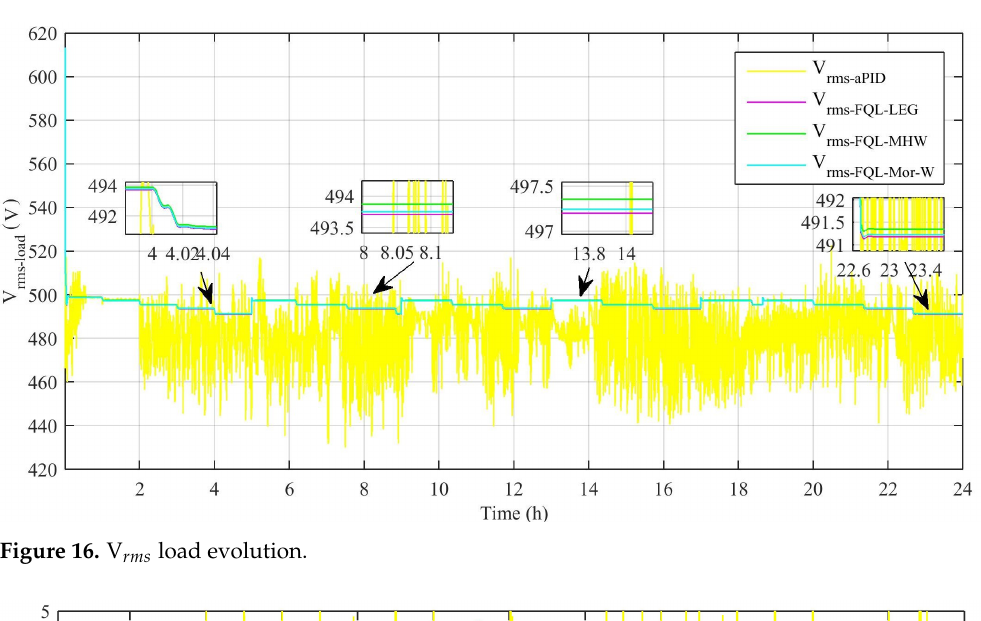
Figure 15. % ∆ f in load current evolution.